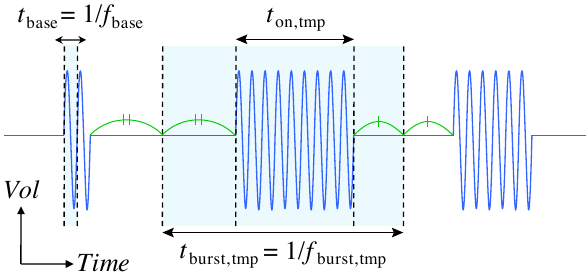
Figure 4. Waveform for the dynamic burst